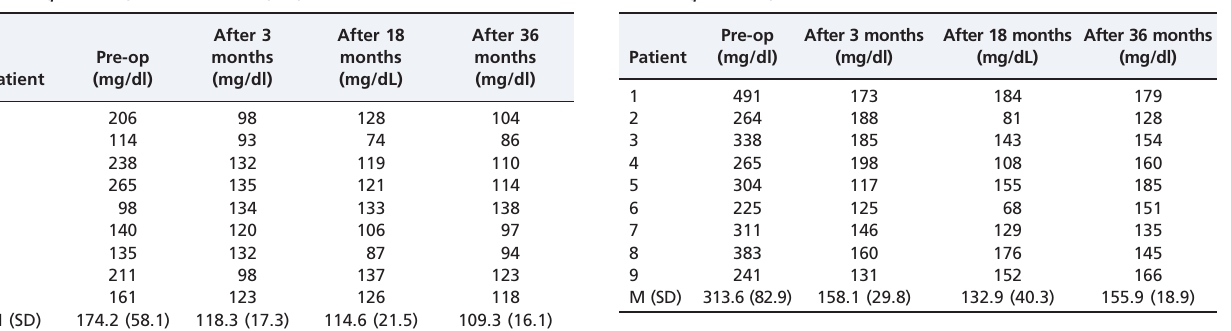
Table 3 - Post-prandial glycemia: Comparison between preoperative values and values at 3, 18, and 36 months after surgery. All postoperative values were significantly lower ( p ,